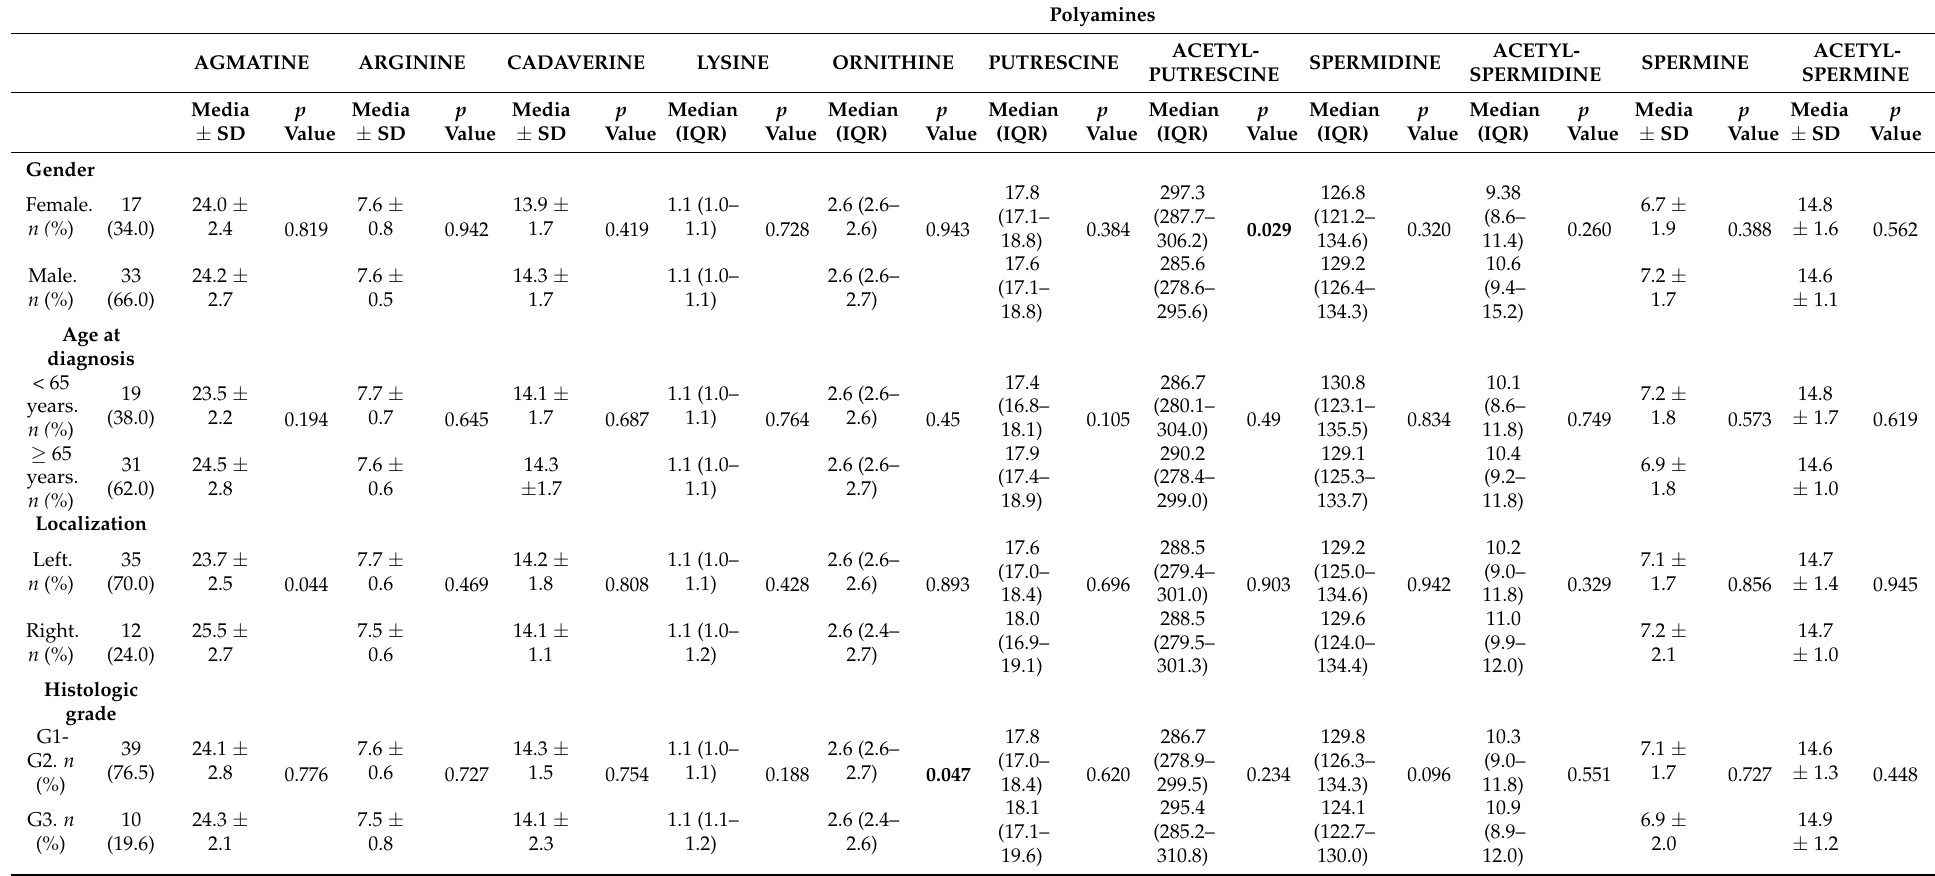
Table 4. Correlation between polyamine levels and clinical-pathological features in patients with colorectal